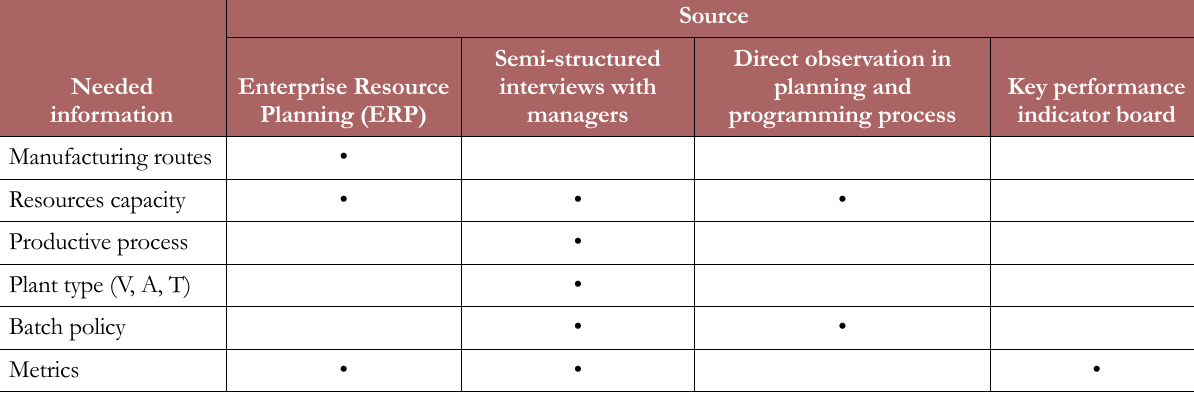
Table 3. Information sources for step